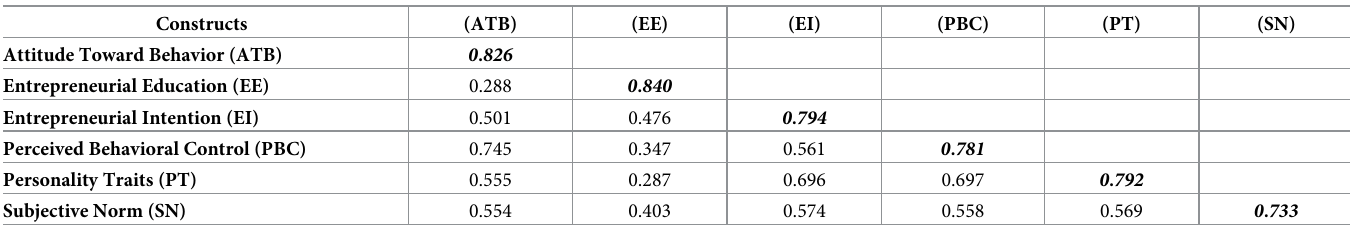
Table 3. Measurement of Squared Correlation and Discriminant Validity.